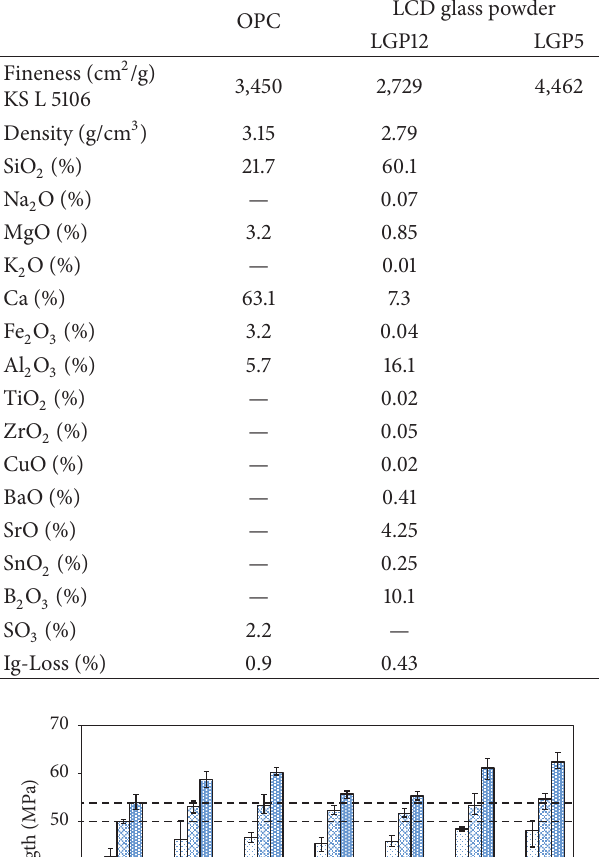
Table 5: Composition of the ordinary Portland cement and LCD glass powder by XRD.